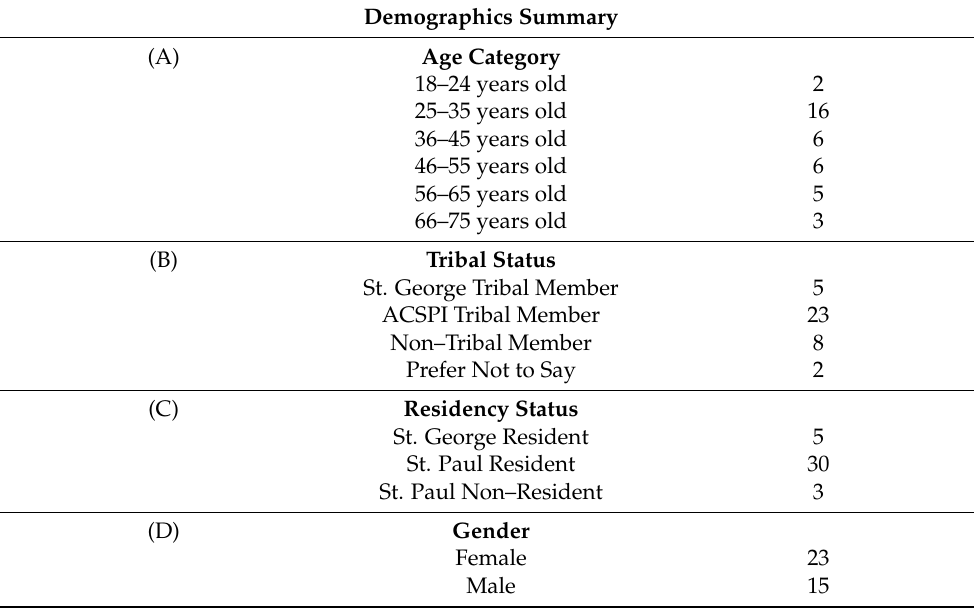
Table A1. Community survey respondent general